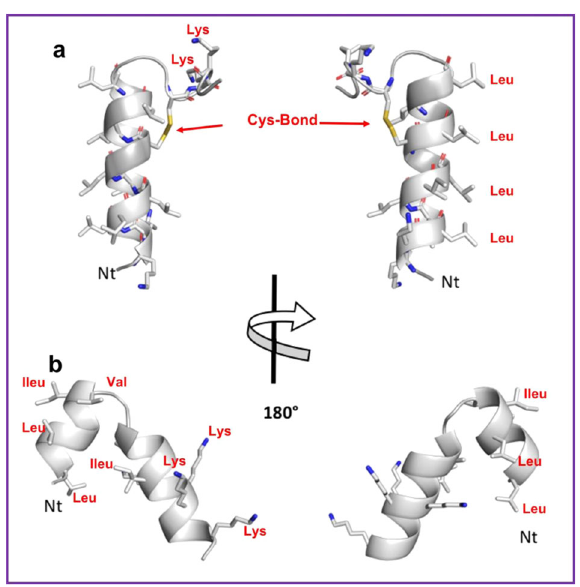
Fig. 2 Predicted 3D structures for peptides. Molecular 3D structures for a HG2, b HG4. Main-chain and side chains are depicted in ribbon and stick representation respectively and coloured according to atom type: Carbon, oxygen and nitrogen in green, red and blue respectively. Two orientations are shown rotated about the shown axis. Ct and Nt as well as selected residues are depicted in the fi gure. Figures were rendered using